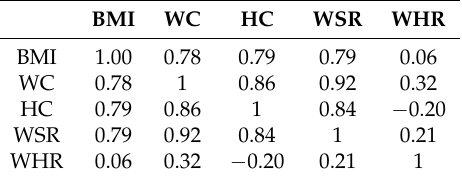
Table 8. Correlations between obesity related variables of Universidad del Norte